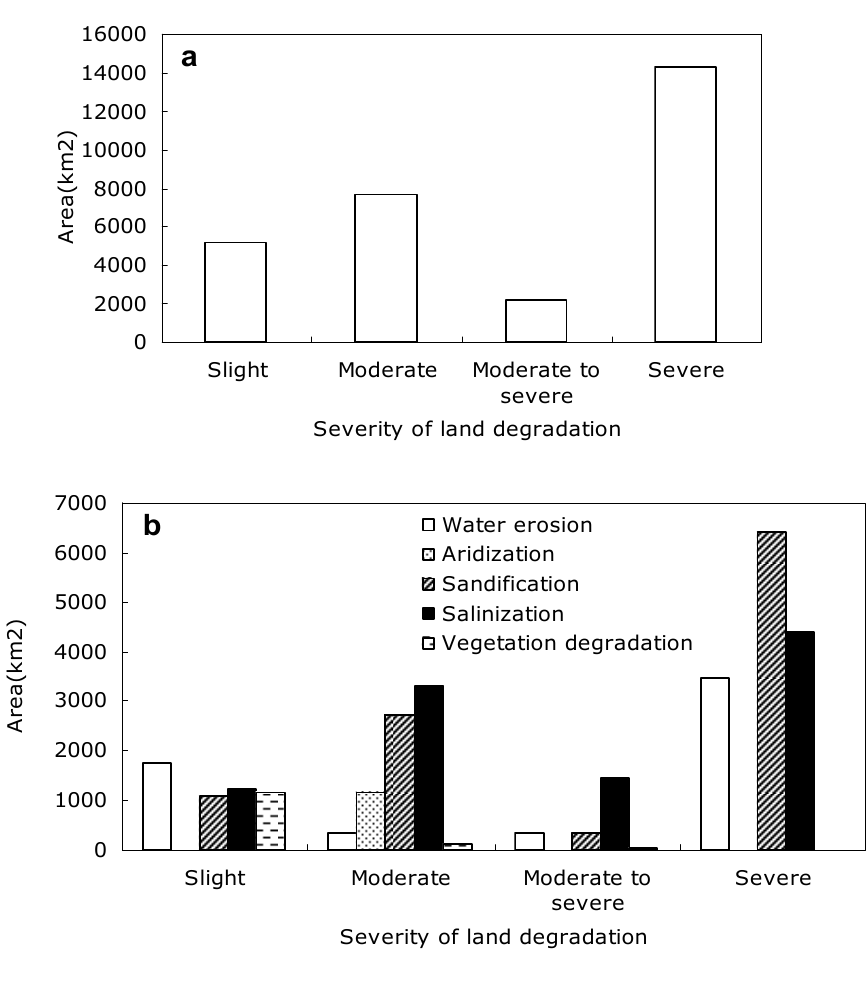
Table 3. Evaluation indexes of degraded land in the Heihe River